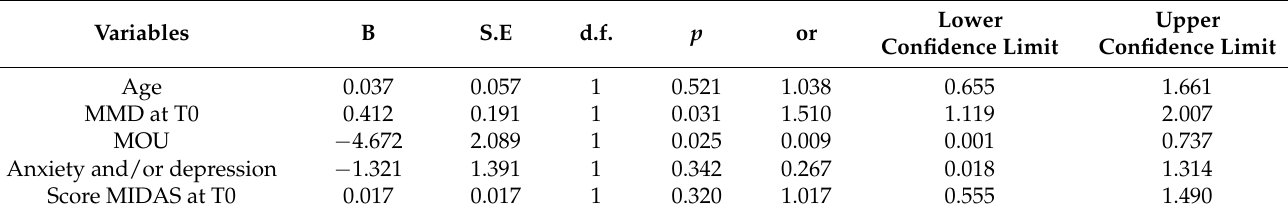
Table 4. Multivariate regression analysis.